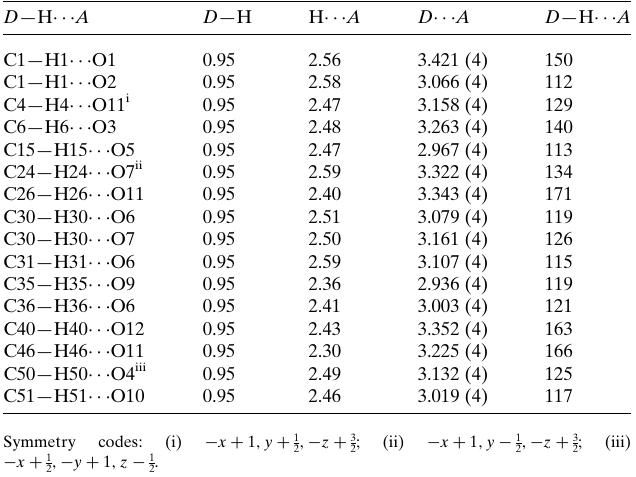
Table 2 Hydrogen-bond geometry (A˚ , (cid:2) ) for ( 2 ).